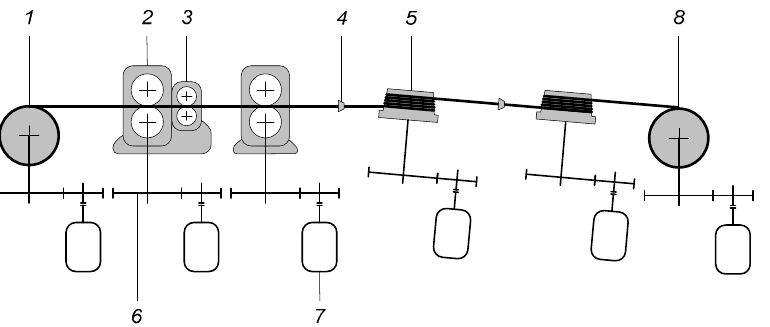
Figure 1. Technological line of the integrated rolling–drawing mill: 1, decoiler; 2, drive stand; 3, idle stand; 4, die block; 5, drum of the drawing block; 6, gearbox; 7, electric actuator; 8, coiler.